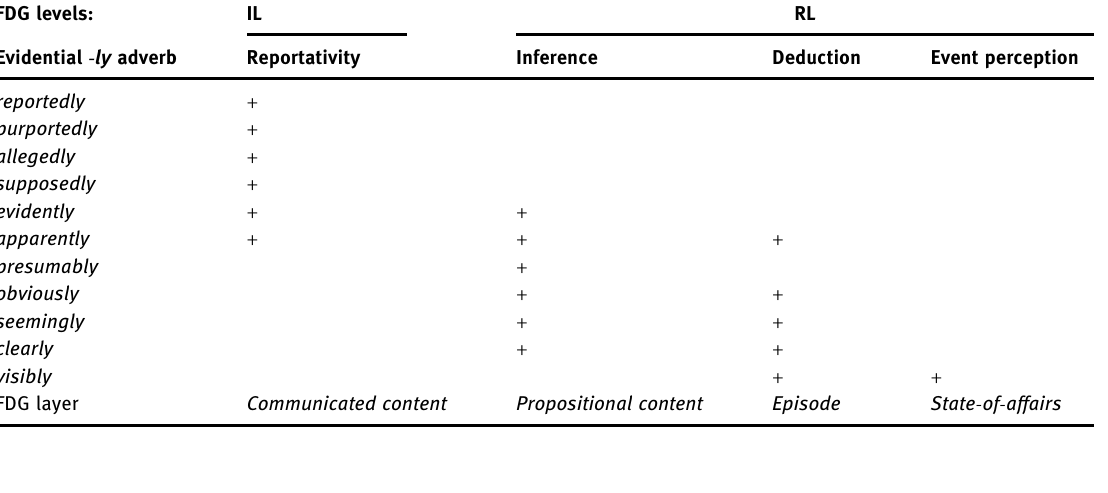
Table 1: FDG classi fi cation of evidential - ly adverbs in main clauses FDG